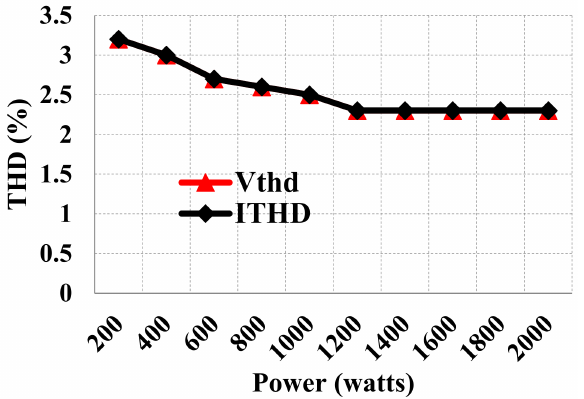
Figure 13. THD at various UPF load levels.